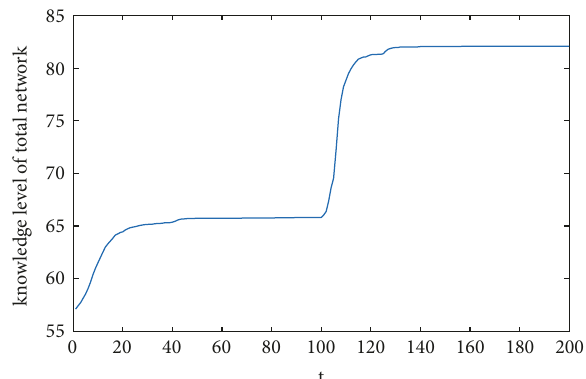
Figure 7: The evolution picture of the collaborative innovation network total technological knowledge